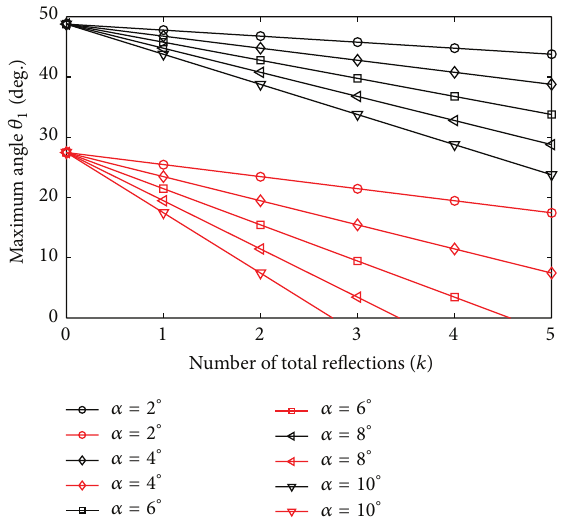
Figure 8: Maximum angle of 𝜃 in with respect to the number of total reflections for different CTPC